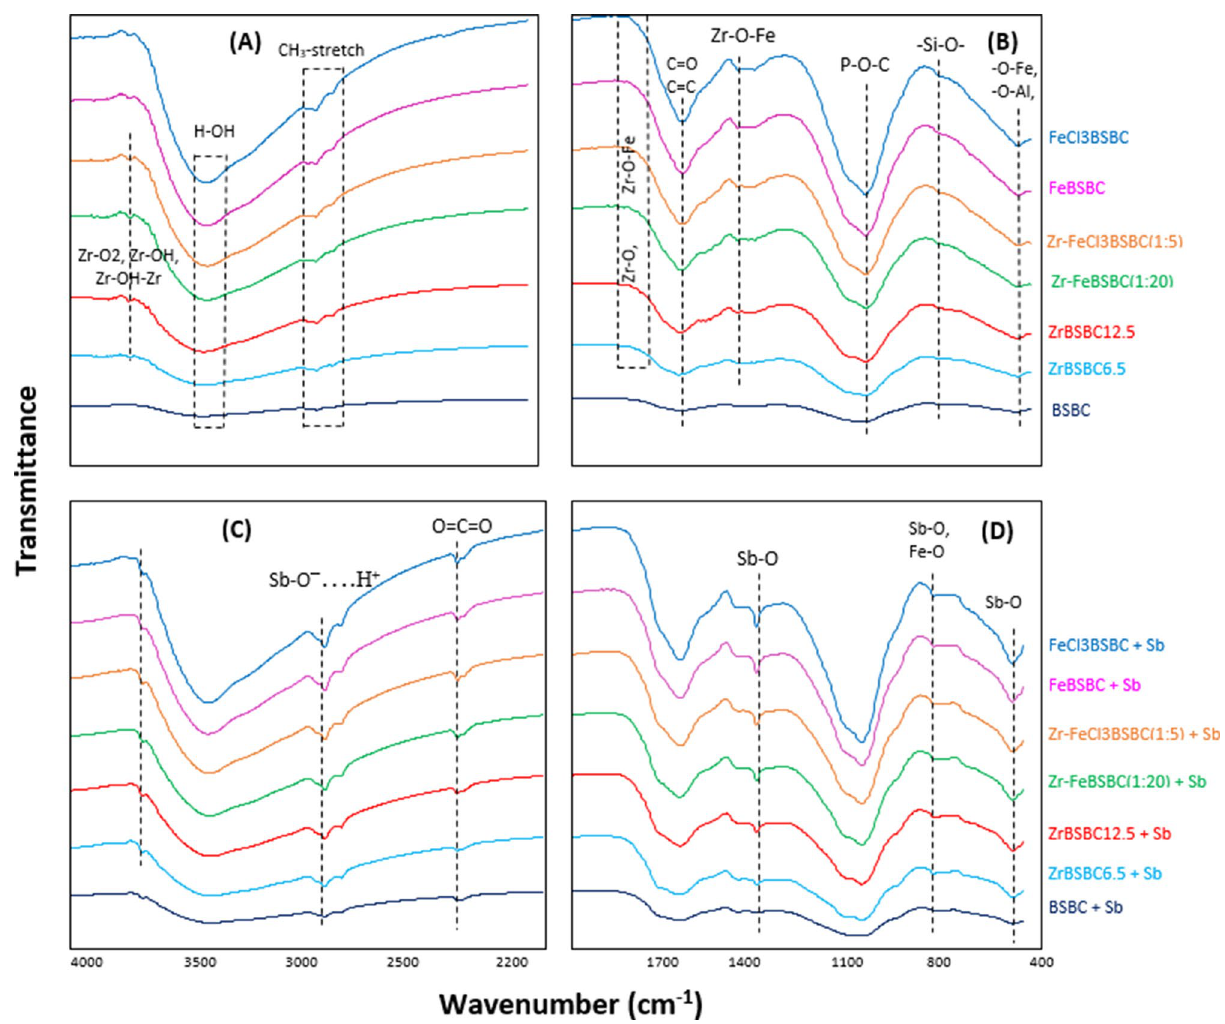
Figure 1. FTIR Spectra of biochars before ( A , B ) and after ( C , D )